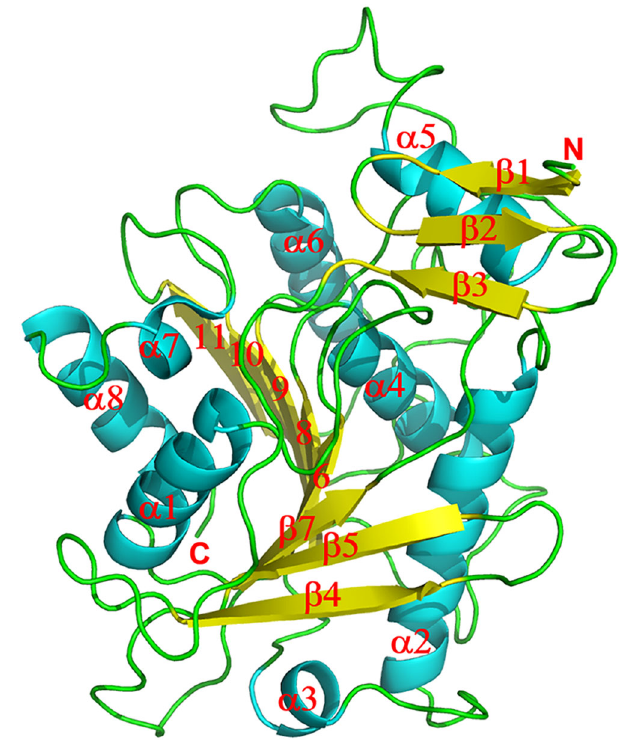
Fig. 8 Ribbon diagram of the P. lobata 2-HID structure. The α helices, β strands and the N- and C-termini are